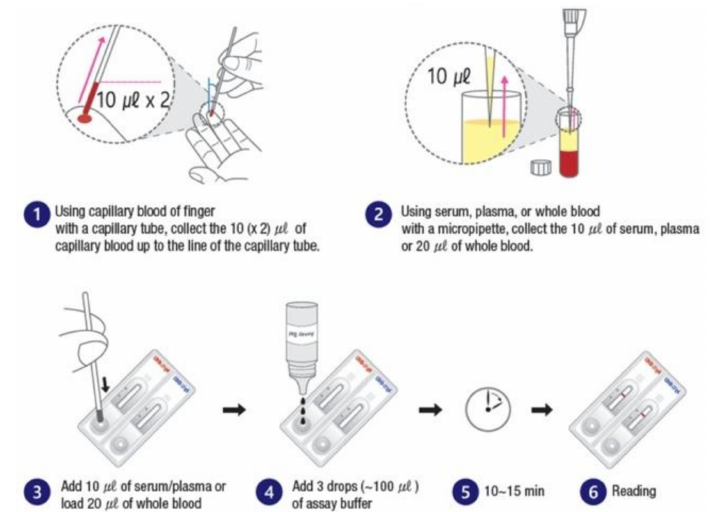
Figure 2. Schematic representation of the assay